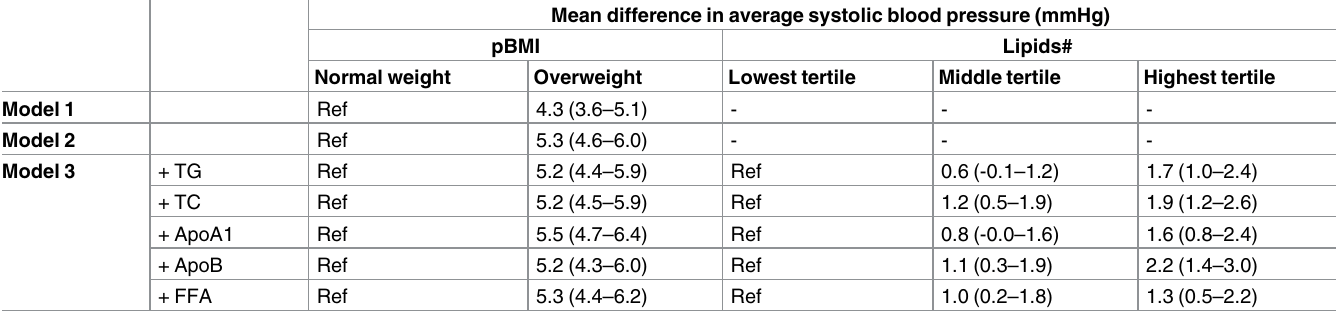
Table 3. Association between pre-pregnancy BMI and systolic blood pressurecourse during pregnancy, with maternal lipids.